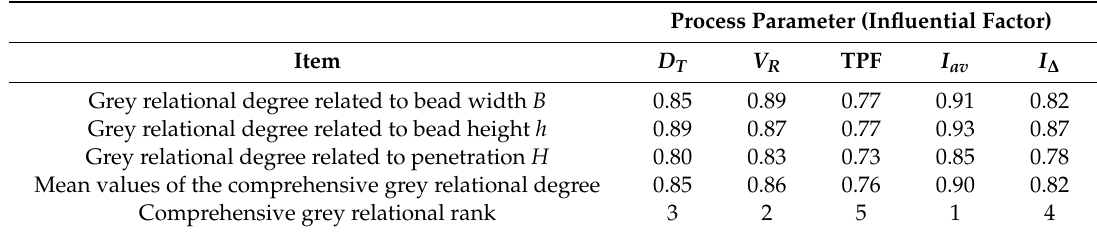
Table 9. Comprehensive grey relational analysis of weld bead forming and process